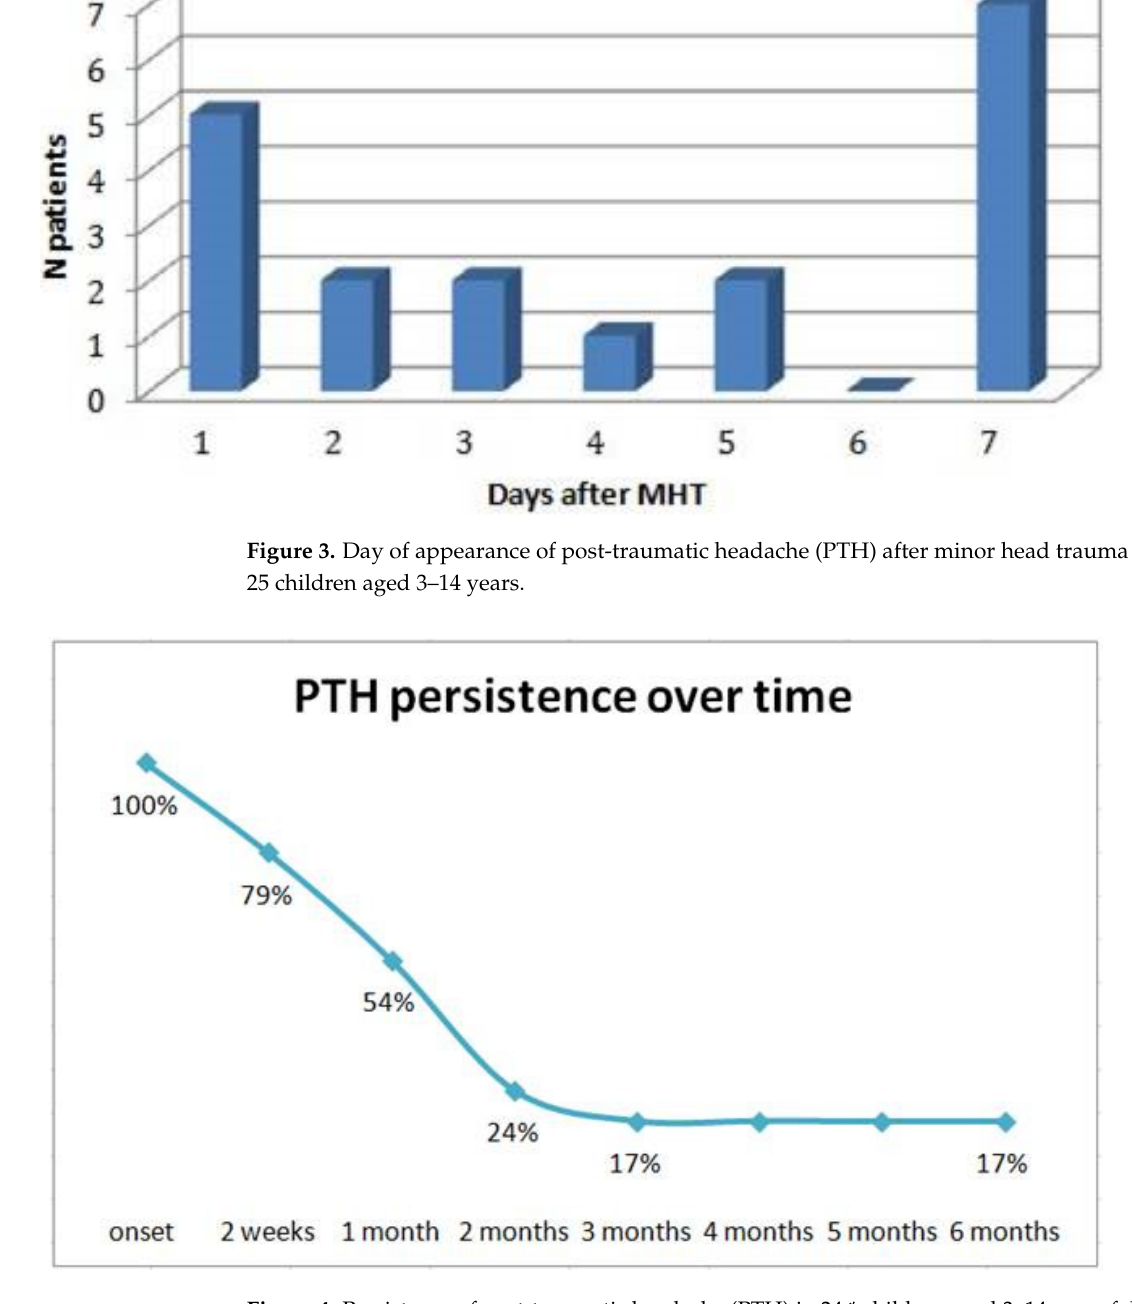
Figure 4. Persistence of post-traumatic headache (PTH) in 24* children aged 3–14 years followed up for 6 months after minor head trauma. *1 out of 25 children complaining PTH was lost at follow-up.